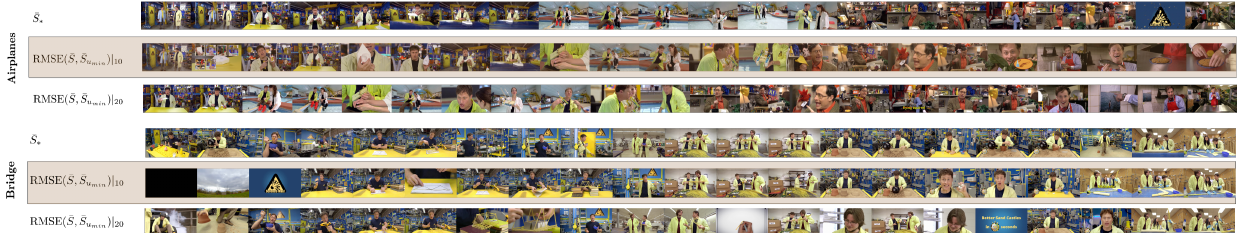
) ) , RMSE ( ¯ S , ¯ S u min min | 10 | 20